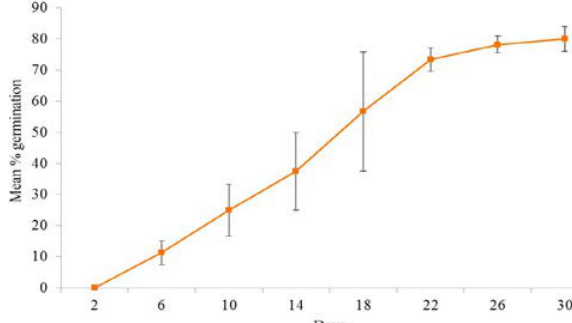
Fig. 1. The mean percentage of spore germination